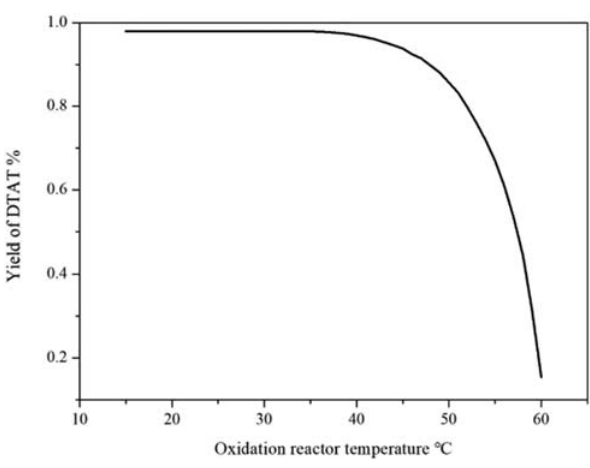
Figure 8: Relationship between the oxidation reactor temperature and the DATA yield.